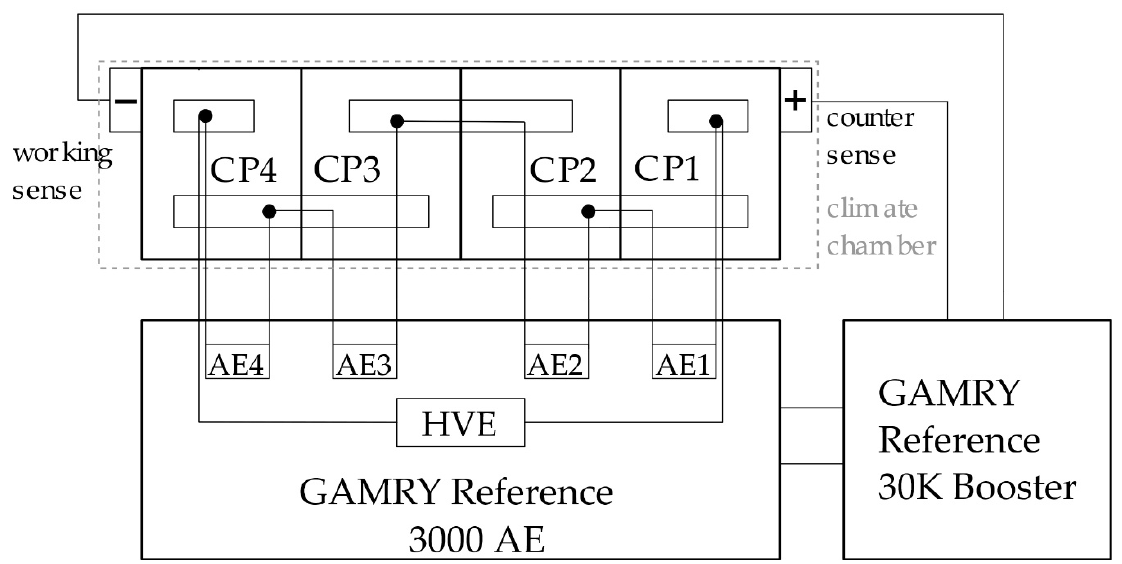
Figure 4. Experimental setup for the EIS measurements in the climate chamber. To generate the impedance spectra, the battery modules or single-battery cells were stimulated by an alternating current with varying frequency, and the voltage response was measured. Here, it is important to pay attention to the causes of measurement errors such as parasitic inductive coupling, electromagnetic interferences, systematic errors caused by contact resistance change, violation of the system requirements (linearity, time invariance, causality) [6,20–22], different location of measurement lines and the use of uncalibrated additional adapters. A booster is needed to generate enough alternating current for EIS with battery modules or very large single cells. The effect on the impedance spectrum when the current excitation is too low is shown in Figure 5.